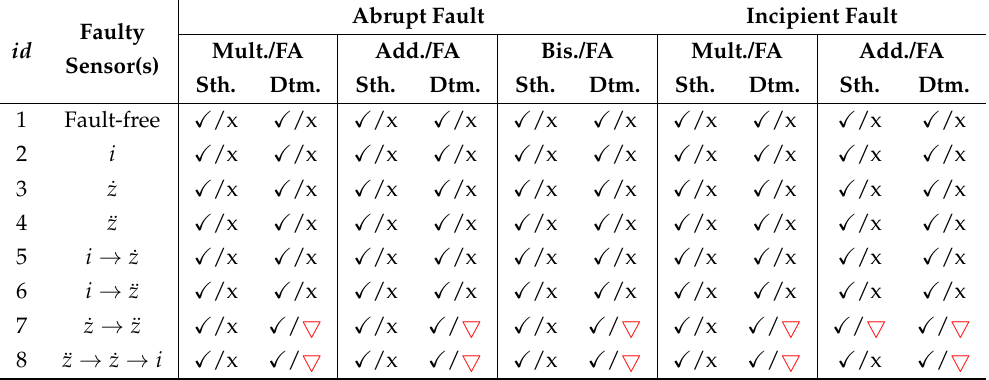
Table 2. Performance with various sensor fault scenarios for the EMS.